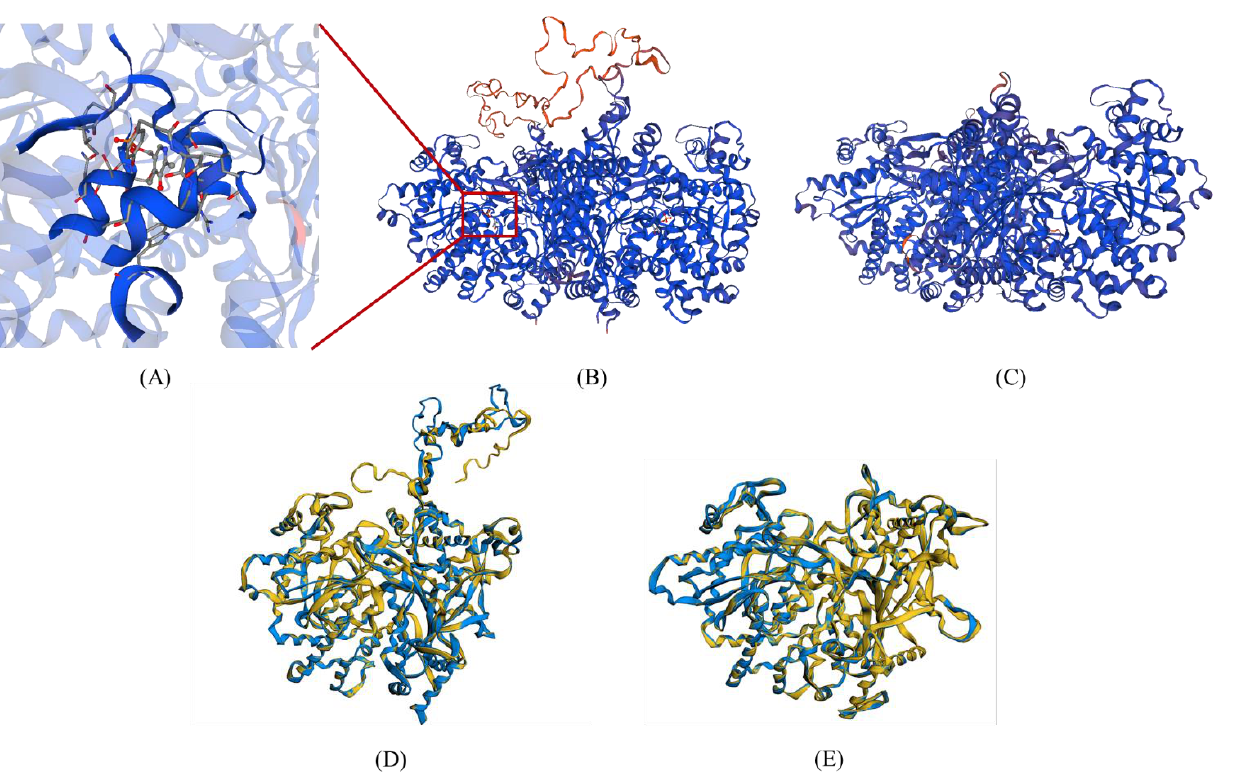
Figure 5. The 3D structures of maize PHO1 and PHO2: ( A ) Amino acid residues and their location involved in the binding of a ligand (PLP); ( B ) Homo-dimeric 3D structure of the PHO1 of Z. mays . The L80 domain (orange) arranged outside the main protein core; ( C ) Homo-dimeric 3D structure of the PHO2 of Z. mays ; ( D ) Superimposed structures of the predicted PHO1 of Z. mays (yellow-colored) over the PHO1 of H. vulgare (blue colored); ( E ) Superimposed structures of the predicted PHO2 of Z. mays (yellow-colored) over the PHO2 of A. thaliana (blue colored).